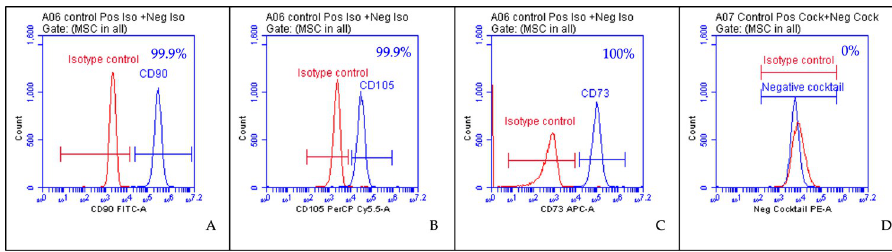
Fig 1. Flow cytometry histogram of hWJ-MSCs for MSC positive markers (CD90, CD105, CD44) and negative markers (CD45, CD34, CD11b, CD19, and HLA-DR). The blue histogram indicates background fluorescence obtained with the specific antibodies, while the red represents the isotype